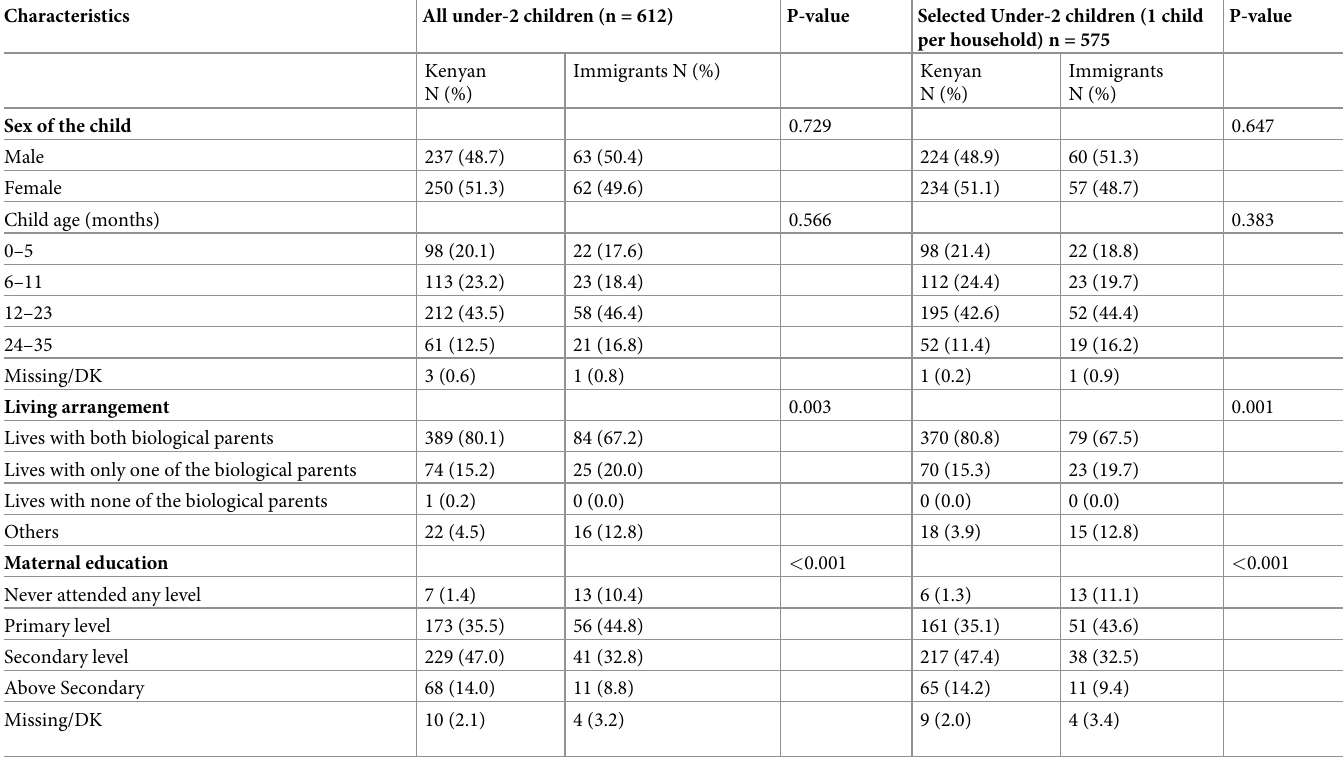
Table 2. Selected background characteristics of children of age two years and